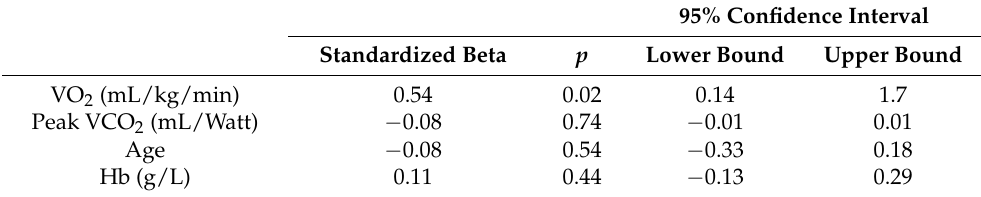
Table 4. Results of the multiple linear